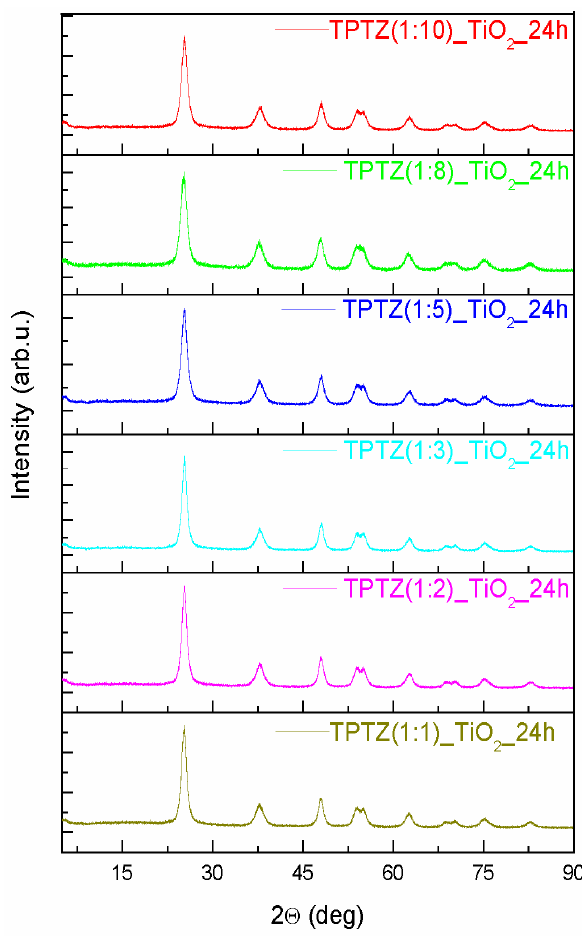
Figure 3. The XRD patterns of the TiO 2 samples prepared by the ionic liquid (2,3,5-triphenyltetrazolium chloride)-assisted solvothermal method at variable IL contents (the IL:TBOT molar ratio ranged from 1:10 to 1:1).